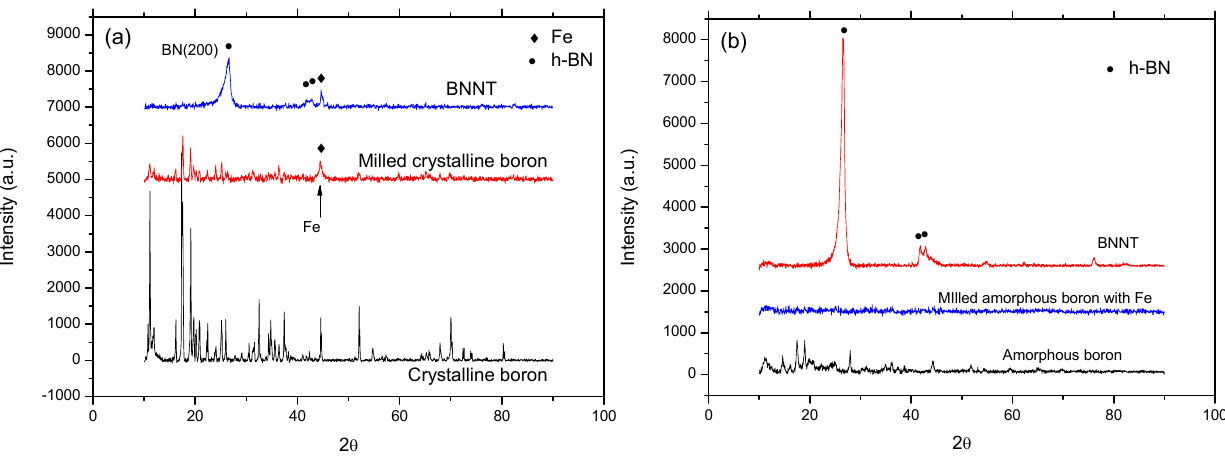
Figure 5. X-ray diffraction (XRD) patterns for annealed samples using the: ( a ) crystalline boron-based precursor; and ( b ) amorphous boron-based precursor with a nozzle-type reactor. BN: boron nitride; and BNNT: boron nitride